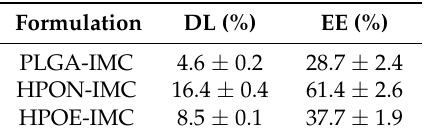
Table 4. DL and EE of the new prepared formulations